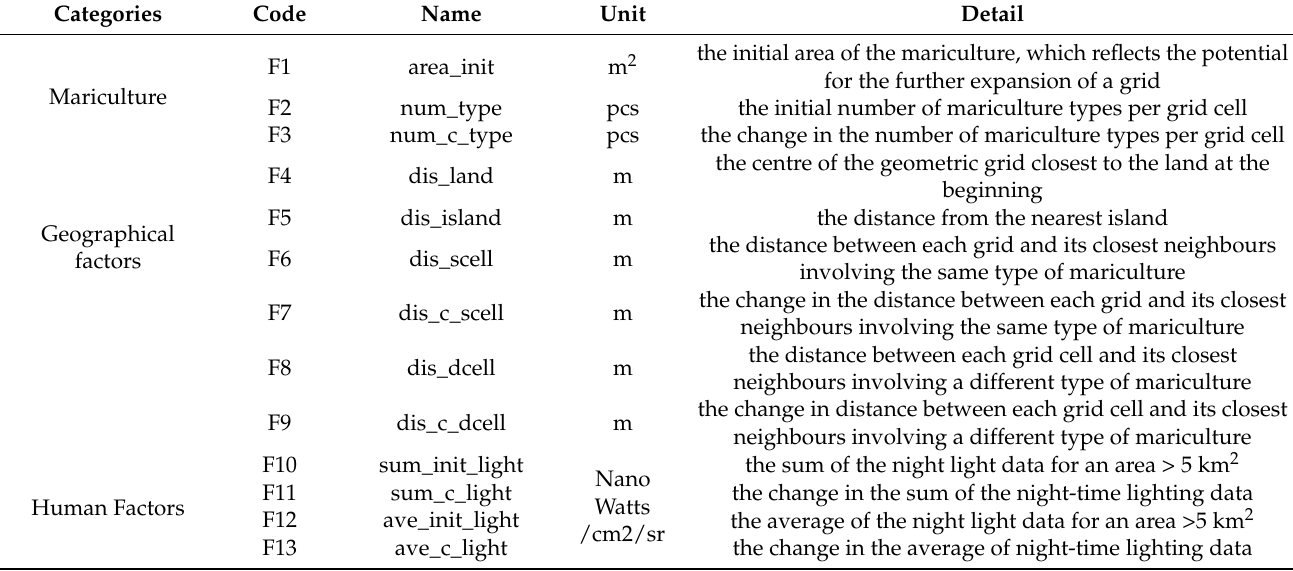
Table 1. Primary driving factors of changes in mariculture.